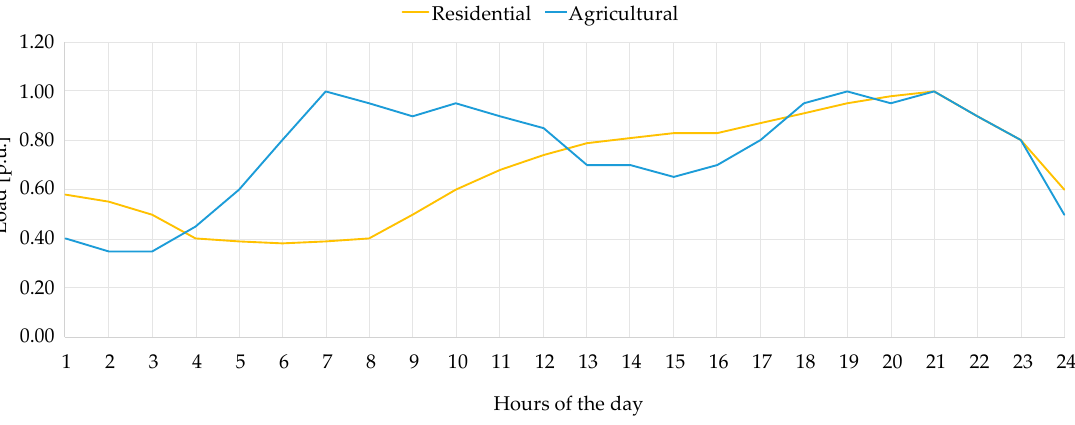
Figure 7. Case study: load profiles.